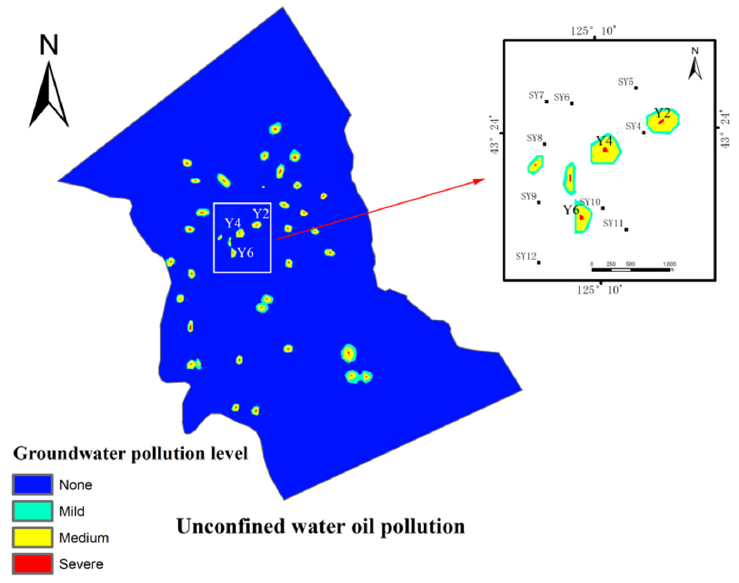
Figure 5. Forecasting oil pollution level mapping in 20 years of unconfined water.